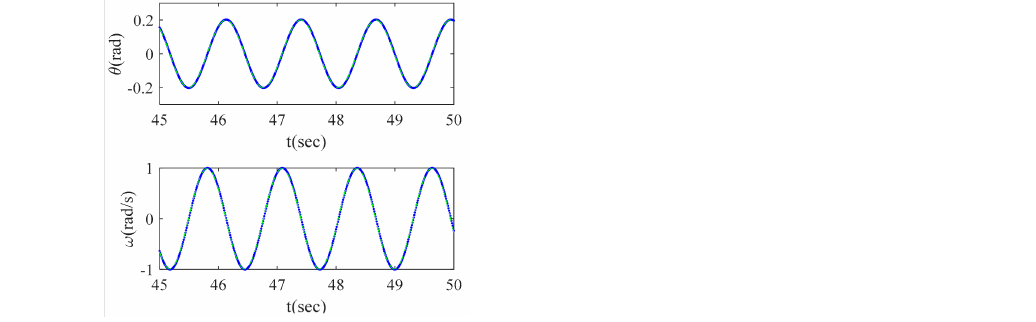
Figure 15. A comparison of two difference methods under the Lie group model with the time step of 0.01 s.